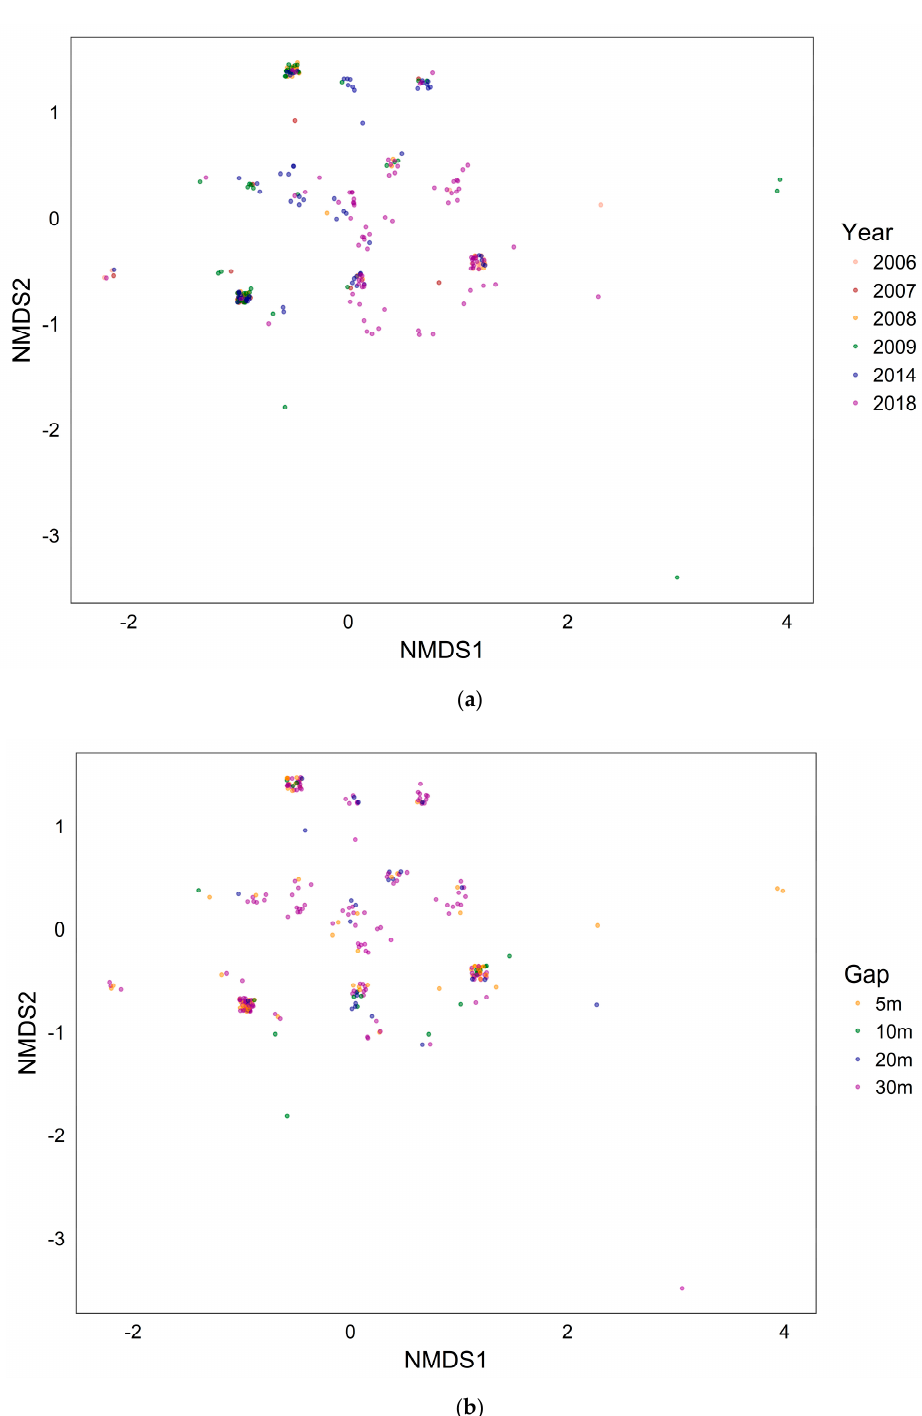
Figure 4. First two axes of two-dimensional nonmetric multidimensional scaling (nMDS) fit based on Jaccard distances ( k = 2, stress = 0.093). Each point denotes a seed trap. ( a ) Different colors denote each measuring year; ( b ) different colors denote each gap mosaic. We excluded species with an extremely low frequency (less than four fruits) from analysis, and used the “jitter” function to display overlapping coordinates.